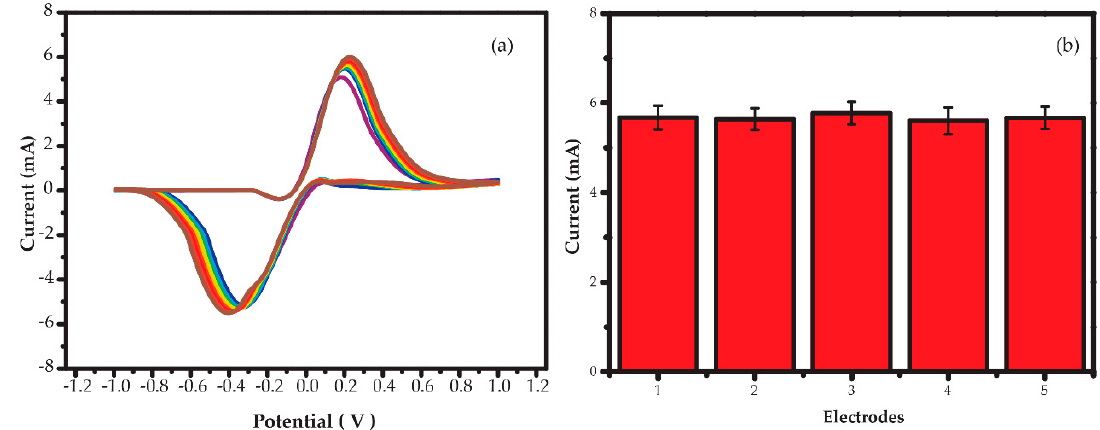
Figure 9. ( a ) Cyclic voltammograms as a function of the number of cycles and ( b ) plot of the anodic peak current of five AgNPs / GO / SPE sensors at a scan rate of 100 mV s − 1 .